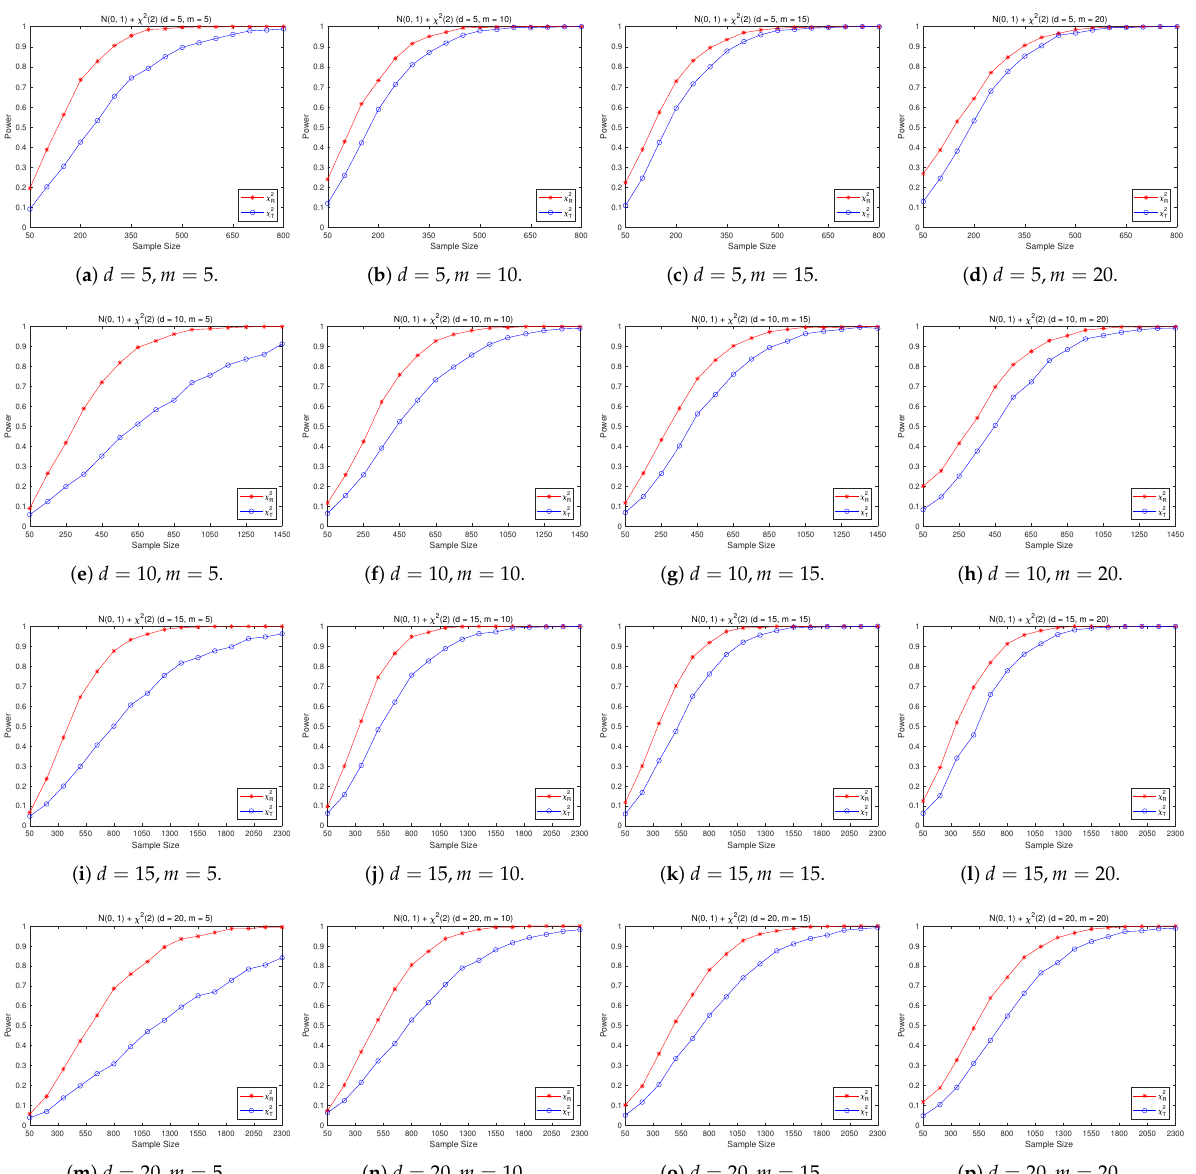
Figure 7. The distribution N ( 0,1 ) + χ 2 ( 2 ) . Red line for RP-chi-square, blue line for traditional